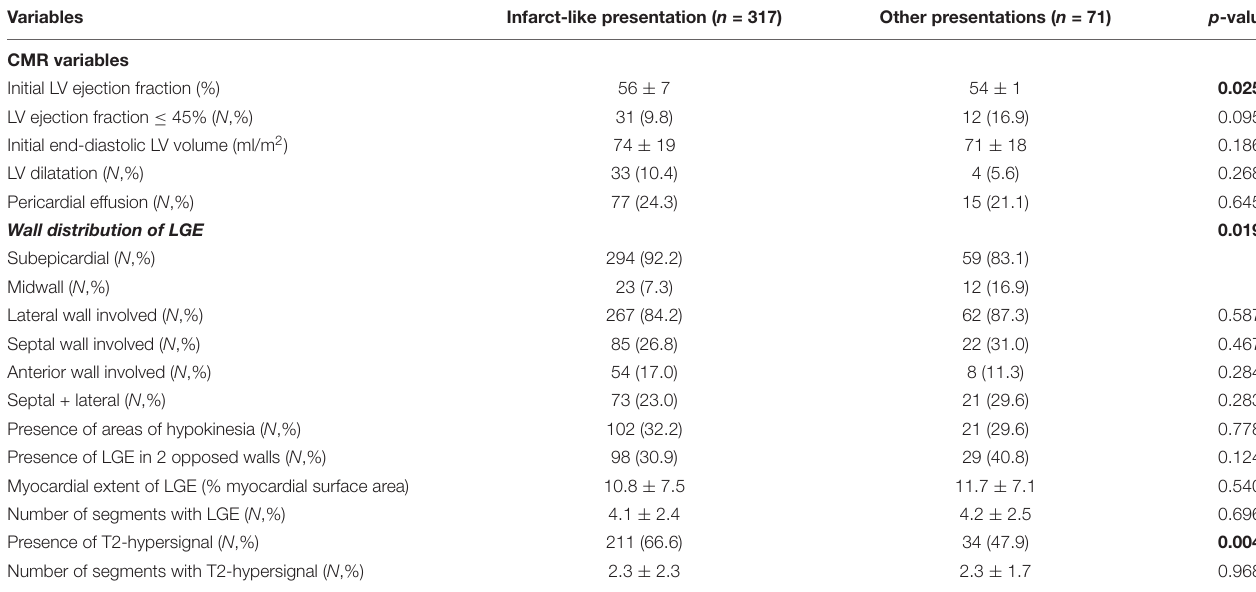
TABLE 2 | CMR characteristics according to initial presentation. Variables Infarct-like presentation ( n = 317) Other presentations ( n =